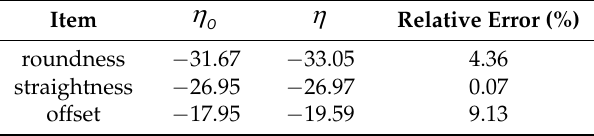
Table 7. S/N ratio and its relative error.